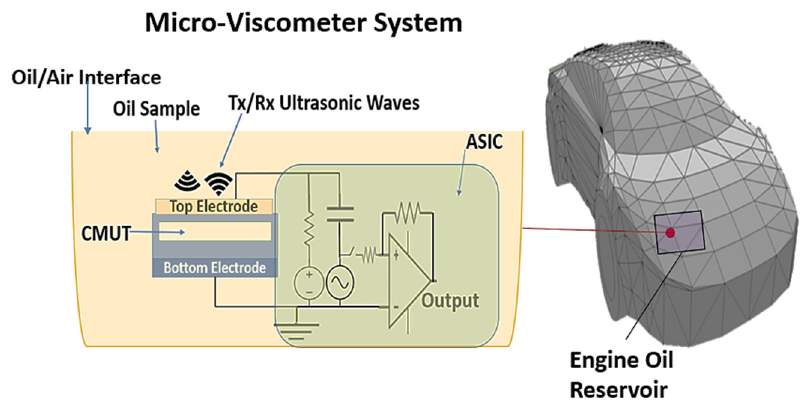
Figure 1. Overall micro-viscometer system design.